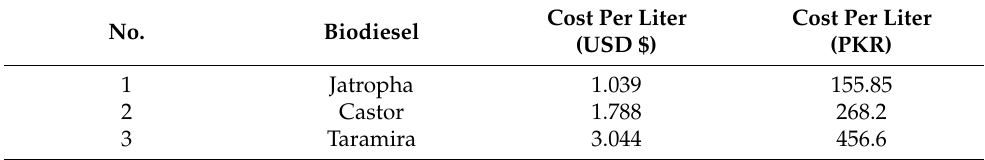
Table 8. Price of producing biodiesel from various non-edible plants [148].